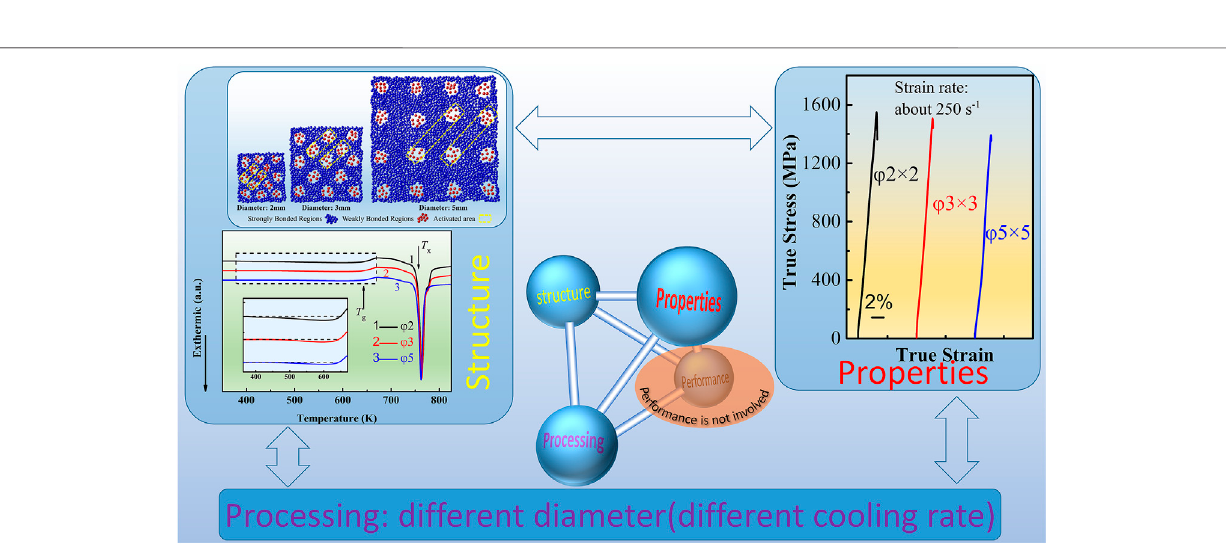
Frontiers in Materials |